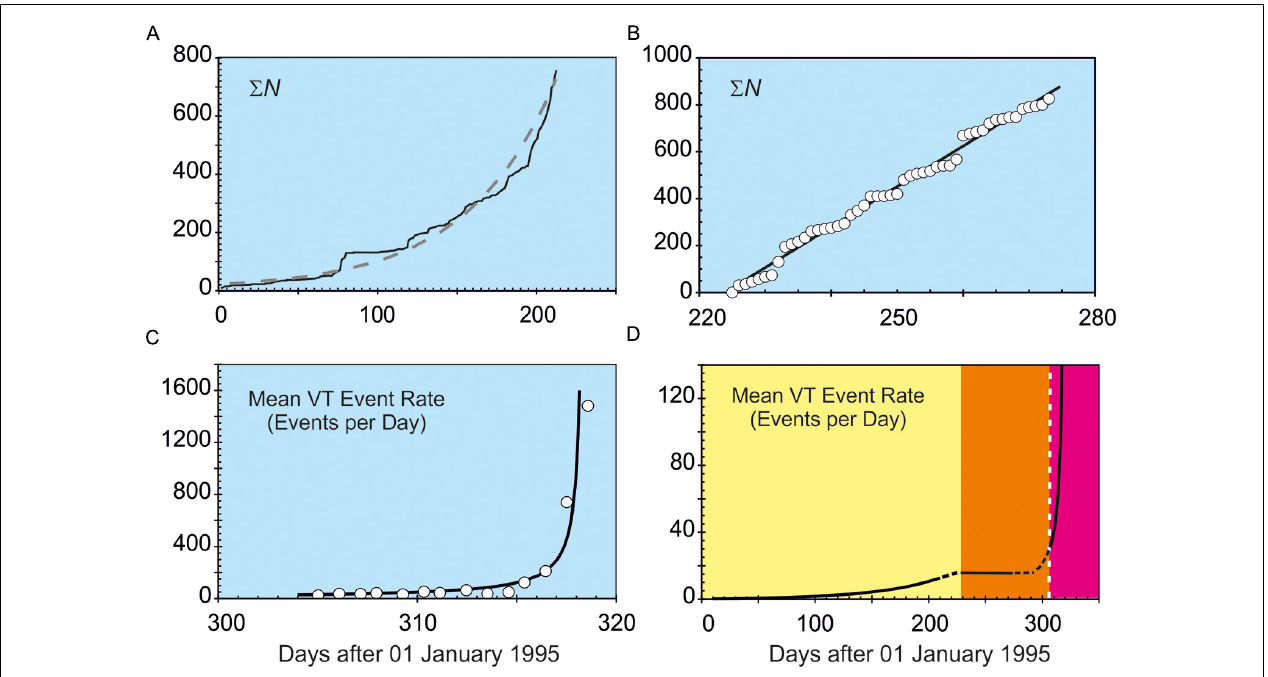
FIGURE 2 | The andesitic-dacitic volcano Soufriere Hills, Montserrat, erupted on 15 November 1995 after 350 years of repose. VT data from three sources are consistent with initial and final episodes of accelerating VT event rate separated by an interval of constant event rate. (A) 01 January–31 July (time t = days 0–212 since 01 January). The mean daily VT event rate ( dashed curve ) increased exponentially as 16 exp ( t /55.6) [data from Shepherd et al. (2002)]. (B) 13 August–30 September ( t = days 225–273). Constant mean VT rate at c. 17 events per day [ line ; data from Gardner and White (2002)]. (C) 01–14 November ( t = days 305–318). The mean daily rate increased hyperbolically ( curve ) as (0.037–0.0024 t ) - 1 until the eruption [ curve ; data from Kilburn and Voight (1998) and Kilburn (2003)]. Additional stations were added to the monitoring network between 18 and 31 July [days 200–212; Gardner and White (2002)] Most VT events had magnitudes between 1.3 and 2.7 (Power et al., 1998; Gardner and White, 2002). (D) . The three datasets suggest that the mean VT trends evolved with time from quasi-elastic ( yellow ), through steady inelastic ( orange ) to accelerating inelastic ( magenta ); dashed portions of the curve are qualitative